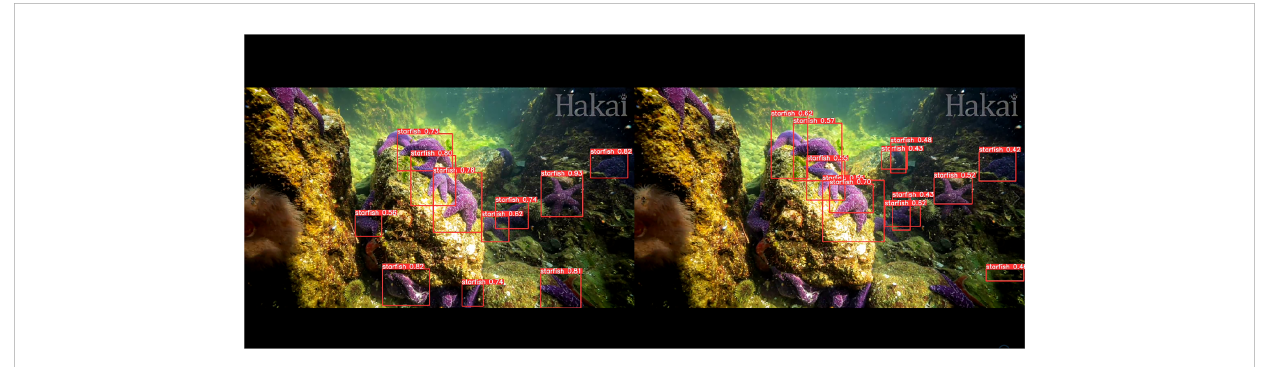
FIGURE 9 Demo on a YouTube video, the con fi dence threshold is 0.4 and the IOU threshold is